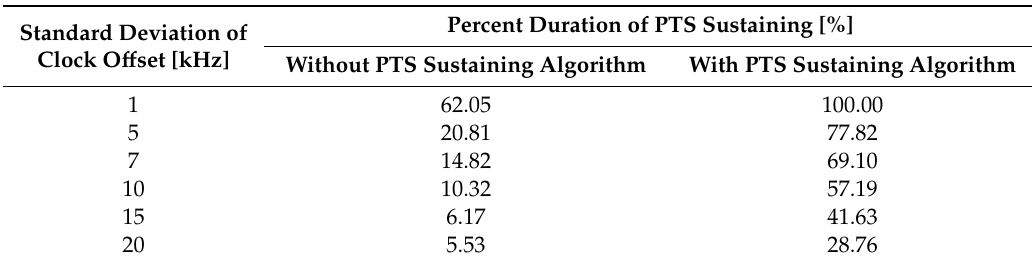
Table 1. Comparison of percent duration of PTS sustaining of PTP